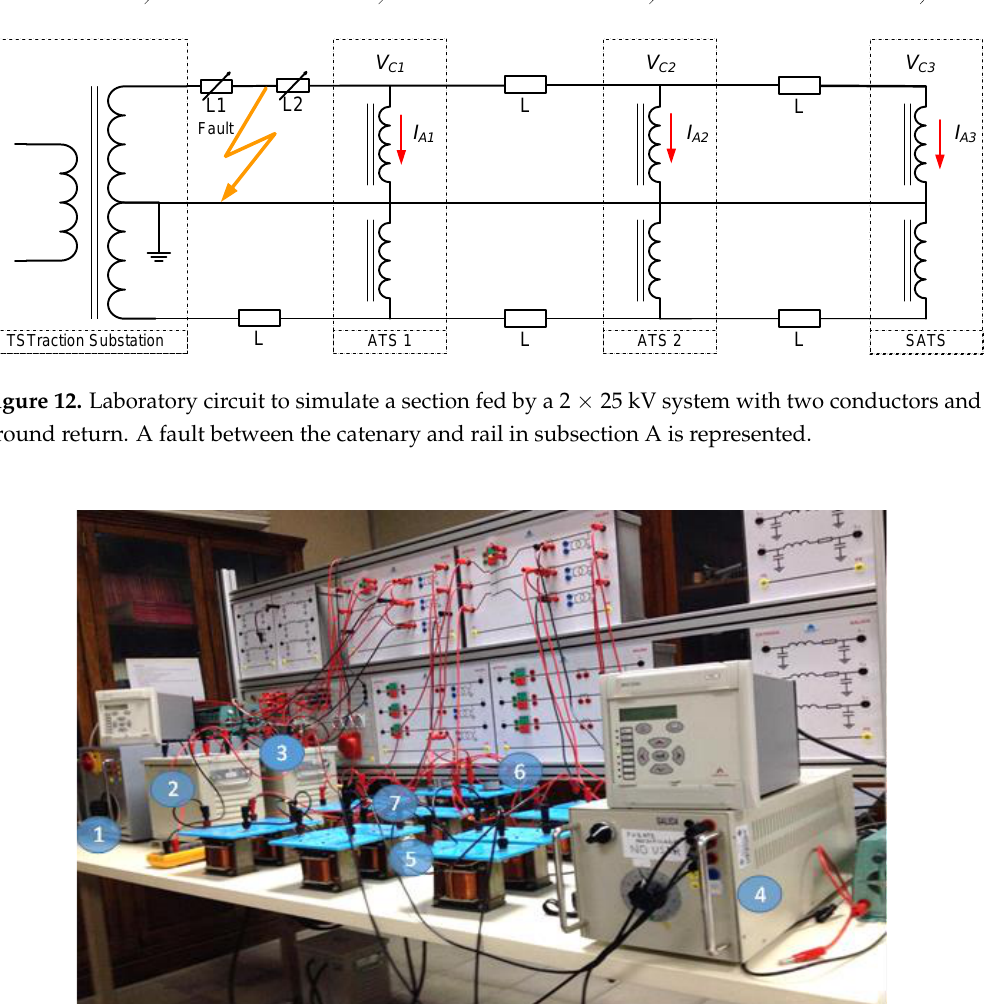
Figure 13. Laboratory setup for 2 × 25 kV power system fault location testing.